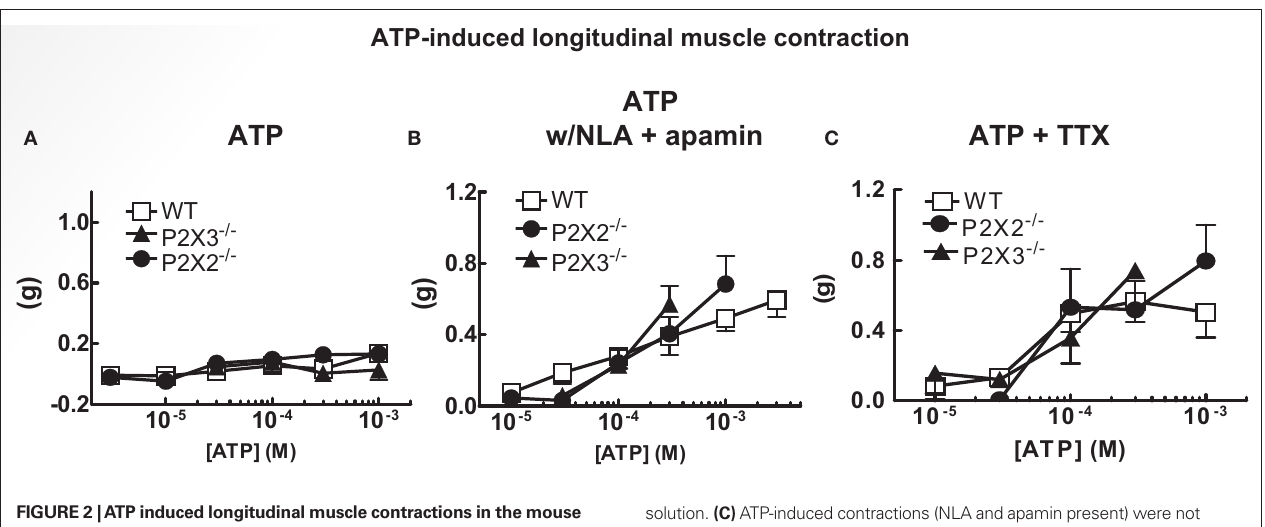
( n = 18) subunit KO mice. (C) Relaxations of the longitudinal muscle caused by nicotine were blocked by NLA (100 μM) and apamin (0.1 μM) in tissues from WT ( n = 14), P2X2 ( n = 9) and P2X3 ( n = 7) subunit KO mice. Data are mean ± SEM. There were no differences between responses obtained in tissues from WT, P2X2 and P2X3 subunit KO mice (two-way ANOVA, P > 0.05).